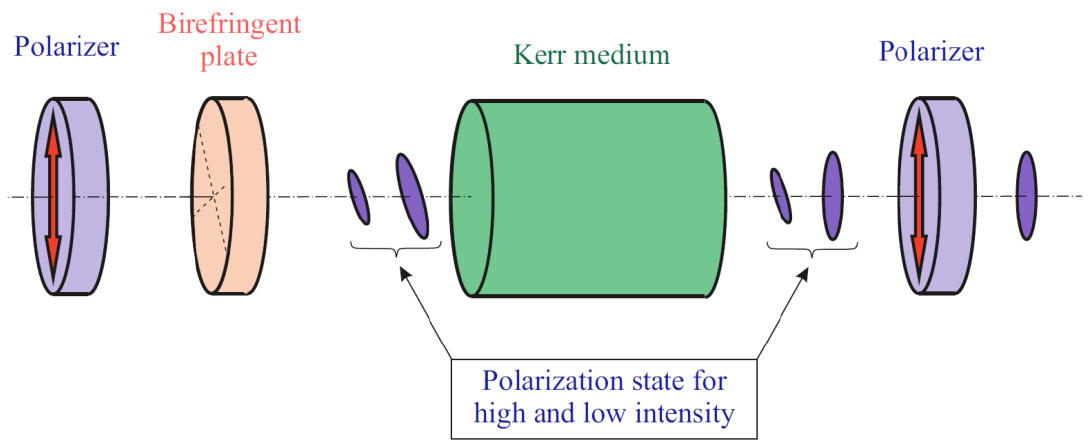
Figure 18. Scheme for obtaining the amplitude self-modulation of radiation in an optical fiber as a result of the nonlinear evolution of polarization.